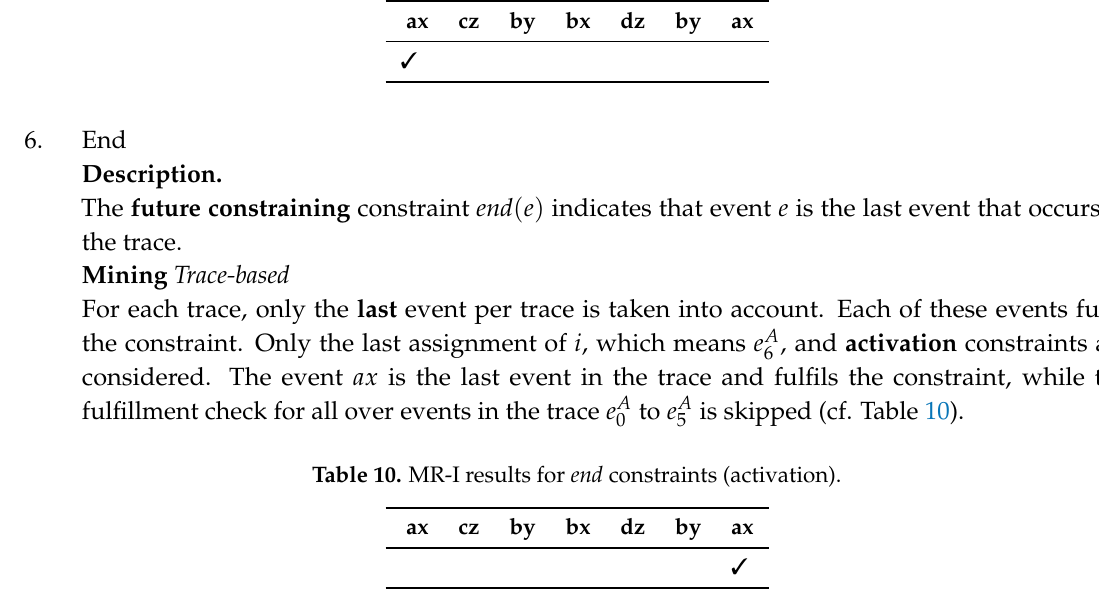
Table 9. MR-I results for init constraints (activation).